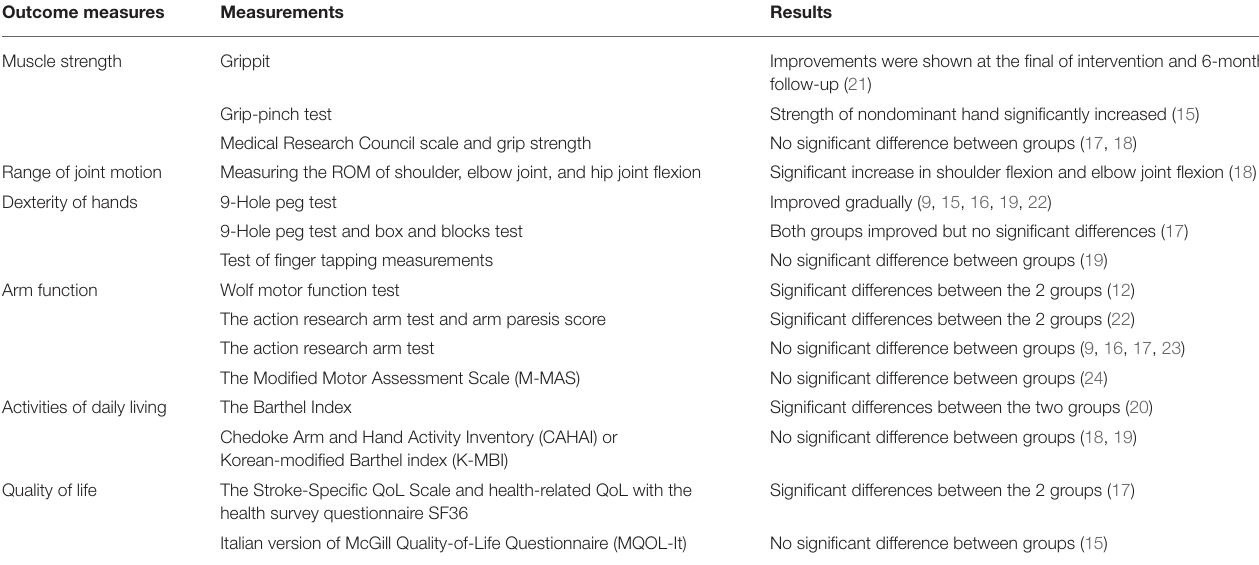
TABLE 2 | The result of outcome measures in the included